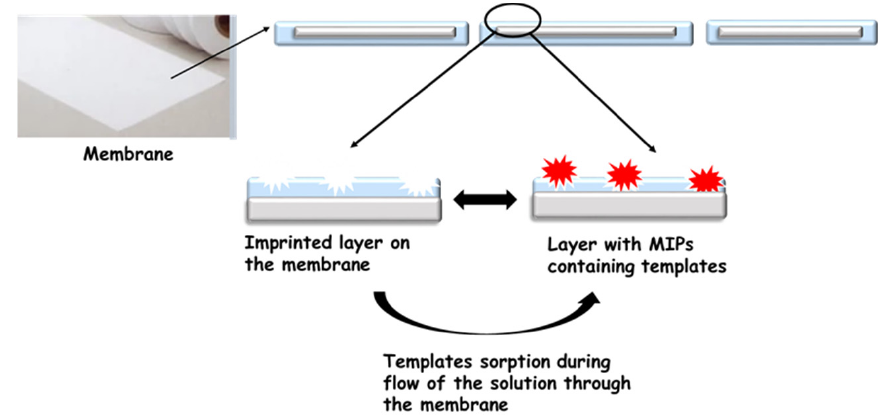
Figure 2. Schematic of the MIM.